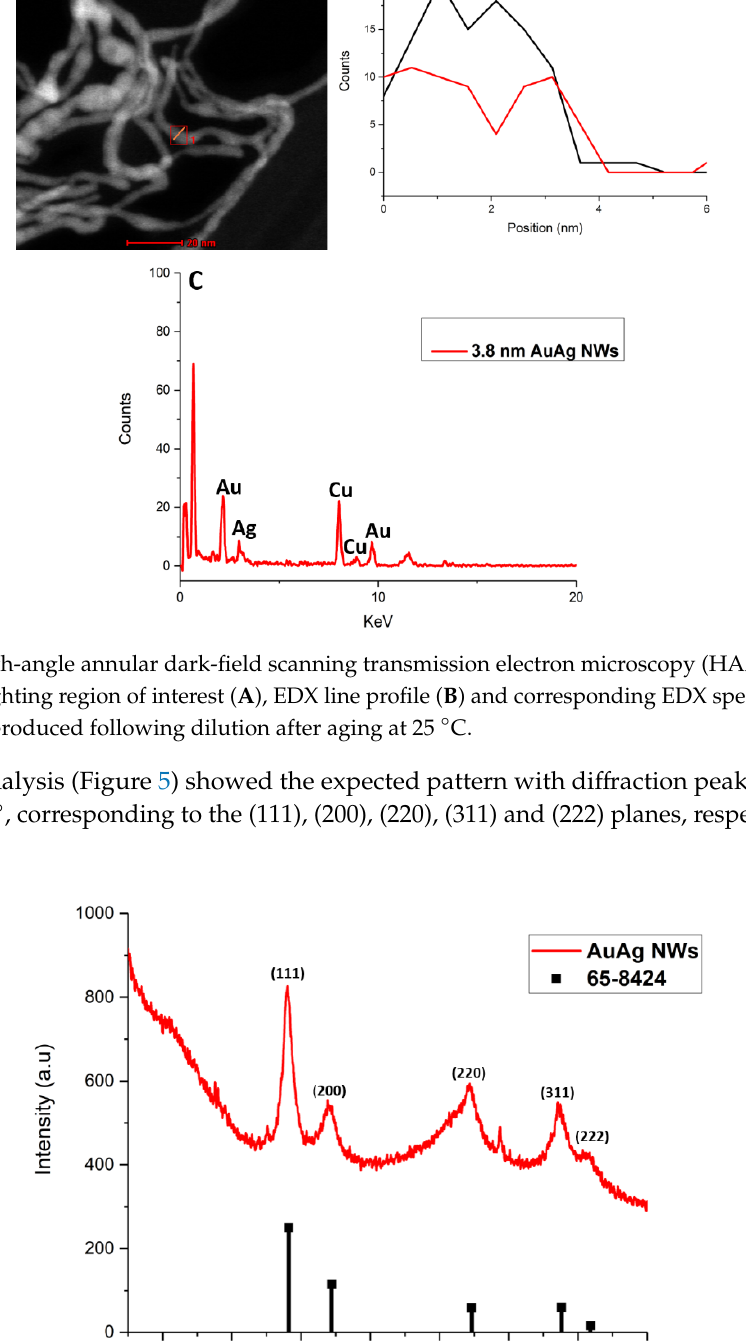
Figure 5. XRD pattern of AuAg NWs produced following dilution after aging at 25 °C.